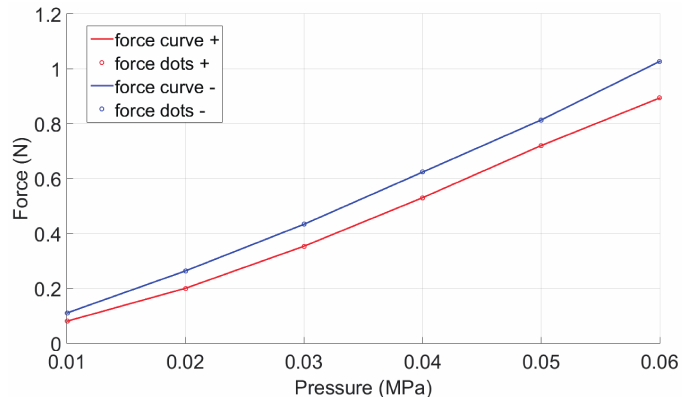
Figure 11. Winding force with various air